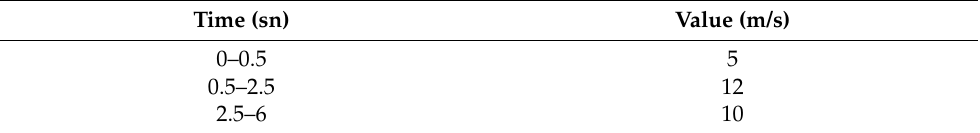
Table 8. Variable wind speed values.